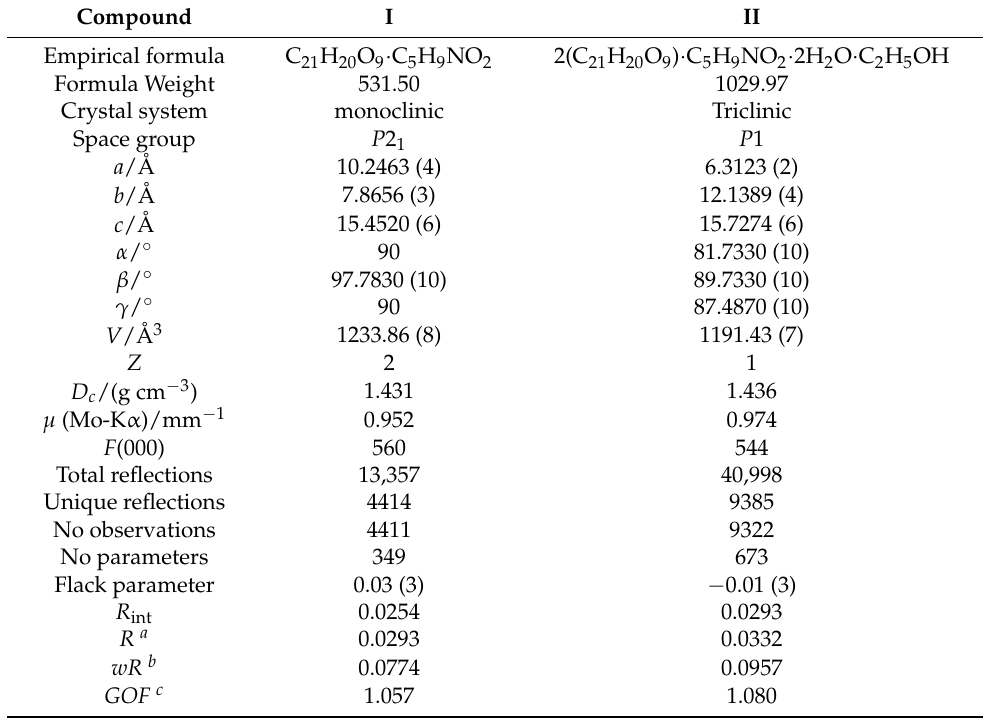
Table 1. Summary of crystallographic data for I and II